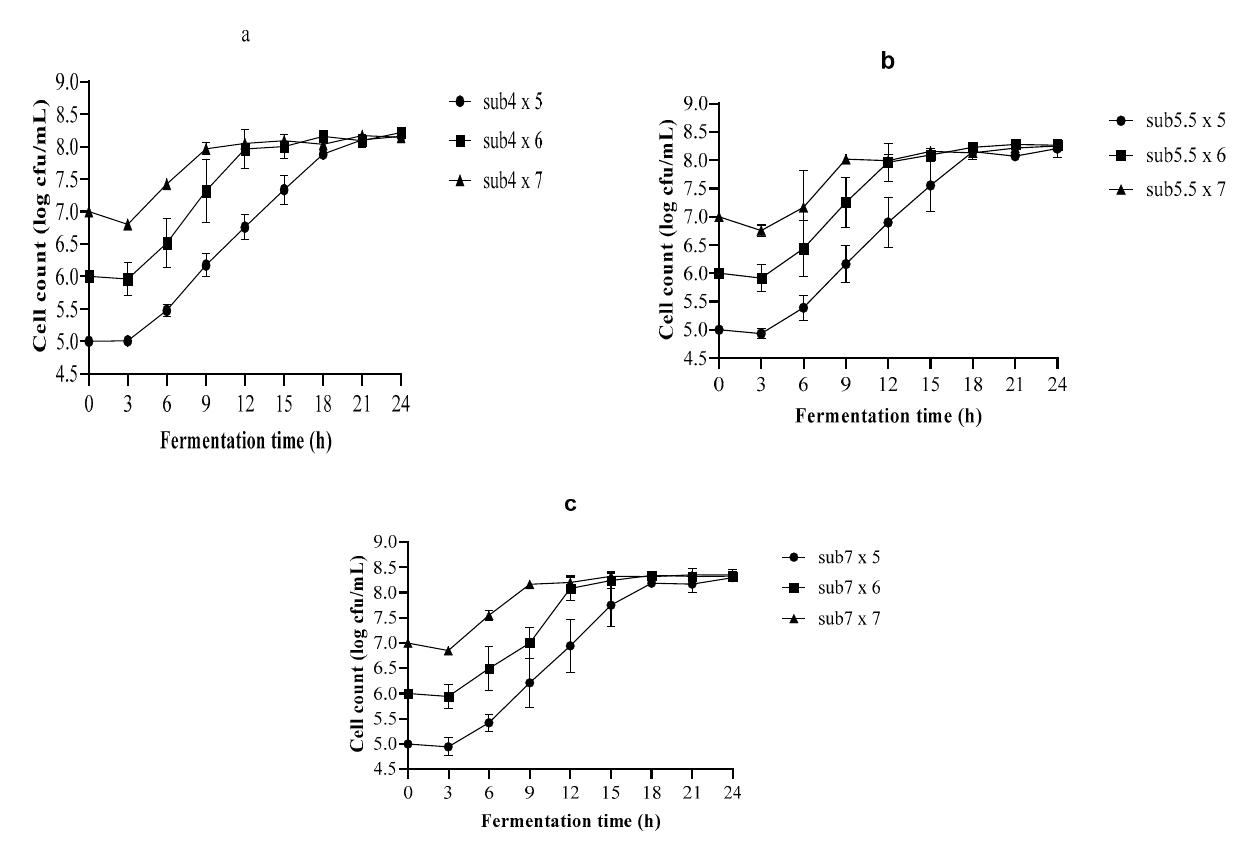
Figure 1. Growth of Lactobacillus plantarum A6 inoculated in ( a ) 4% w/v , ( b ) 5.5% w/v , and ( c ) 7% w/v substrate; sub4 × 5, 4% w/v substrate inoculated with 5 log cfu/mL; sub4 × 6, 4% w/v substrate inoculated with 6 log cfu/mL; sub4 × 7, 4% w/v substrate inoculated with 7 log cfu/mL; sub5.5 × 5, 5.5% w/v substrate inoculated with 5 log cfu/mL; sub5.5 × 6, 5.5% w/v substrate inoculated with 6 log cfu/mL; sub5.5 × 7, 5.5% w/v substrate inoculated with 7 log cfu/mL; sub7 × 5, 7% w/v substrate inoculated with 5 log cfu/mL; sub7 × 6, 7% w/v substrate inoculated with 6 log cfu/mL; sub7 × 7, 7% w/v substrate inoculated with 7 log cfu/mL.